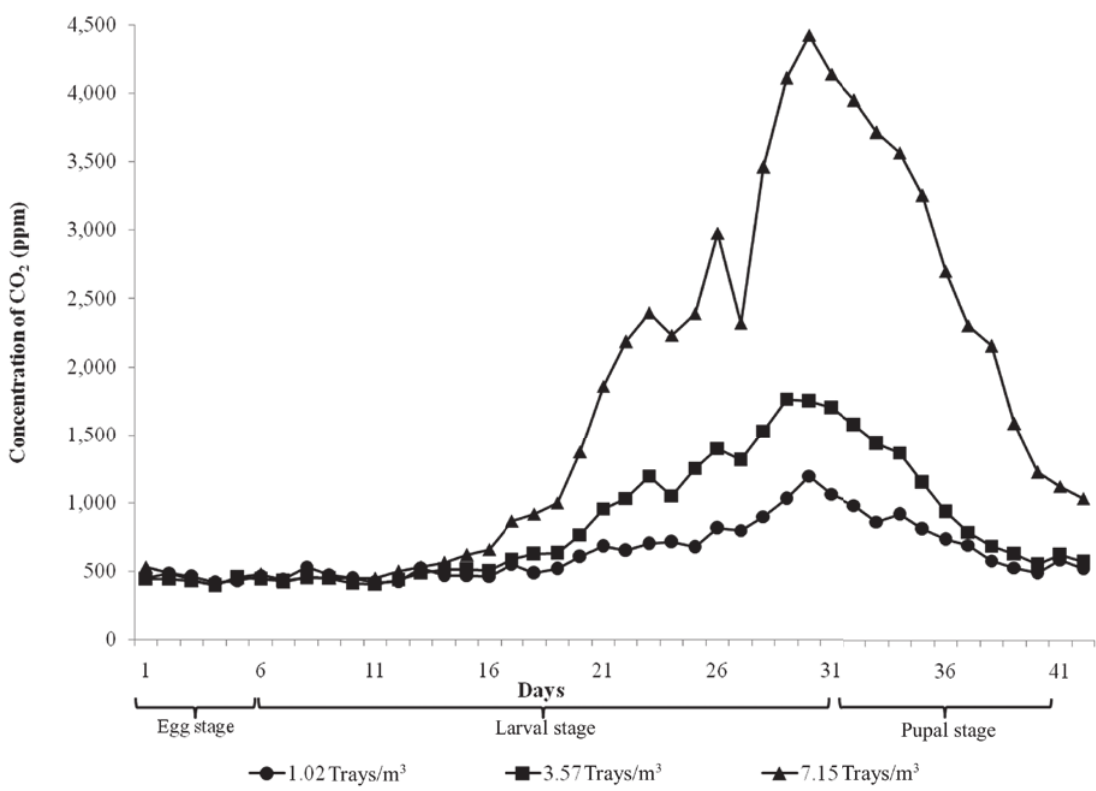
Figure 2 - Concentration of CO (ppm) during the egg-to-adult period of A. kuehniella , inside the rearing rooms with 2 different quantities of trays per m 3 . Temp.: 25 ±3°C, photophase: 14h. The arrows indicate the maximum production of CO in the three conditions studied, corresponding to the 5 th instar of the larval stage. 2